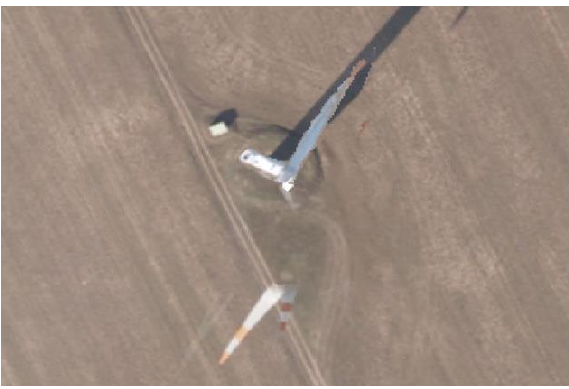
Figure 20. TrueDOP presentation of a wind millXX